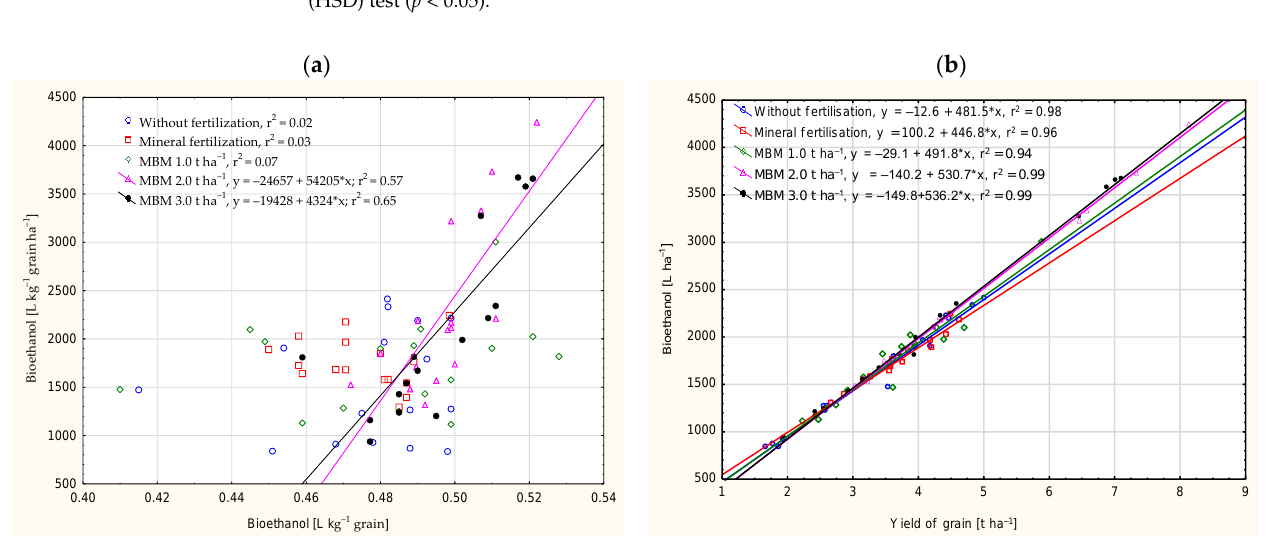
Figure 7. Dependence of bioethanol yield on volume obtained from 1.0 kg – 1 of grain ( a ) and grain harvest from 1.0 ha – 1 ( b ) (calculated at significance α = 0.05). MBM— Meat and Bone Meal.